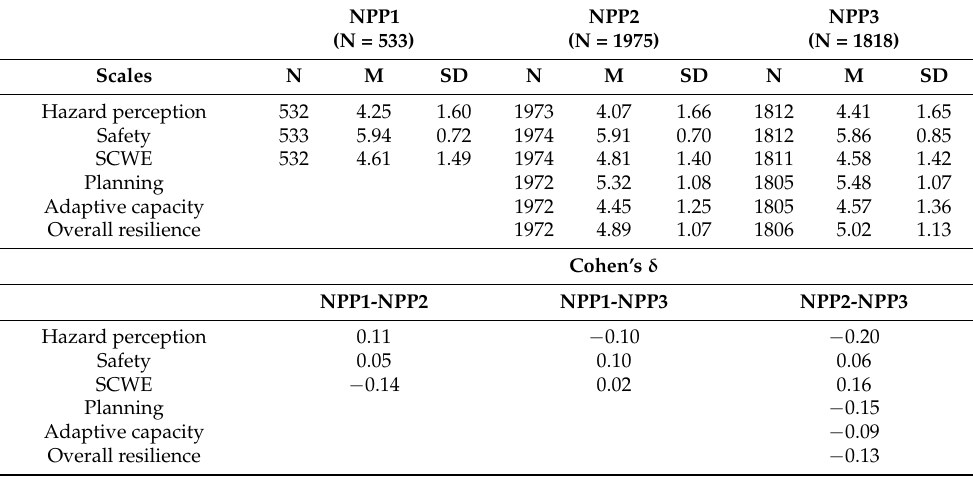
Table 6. Descriptive statistics of the scales by